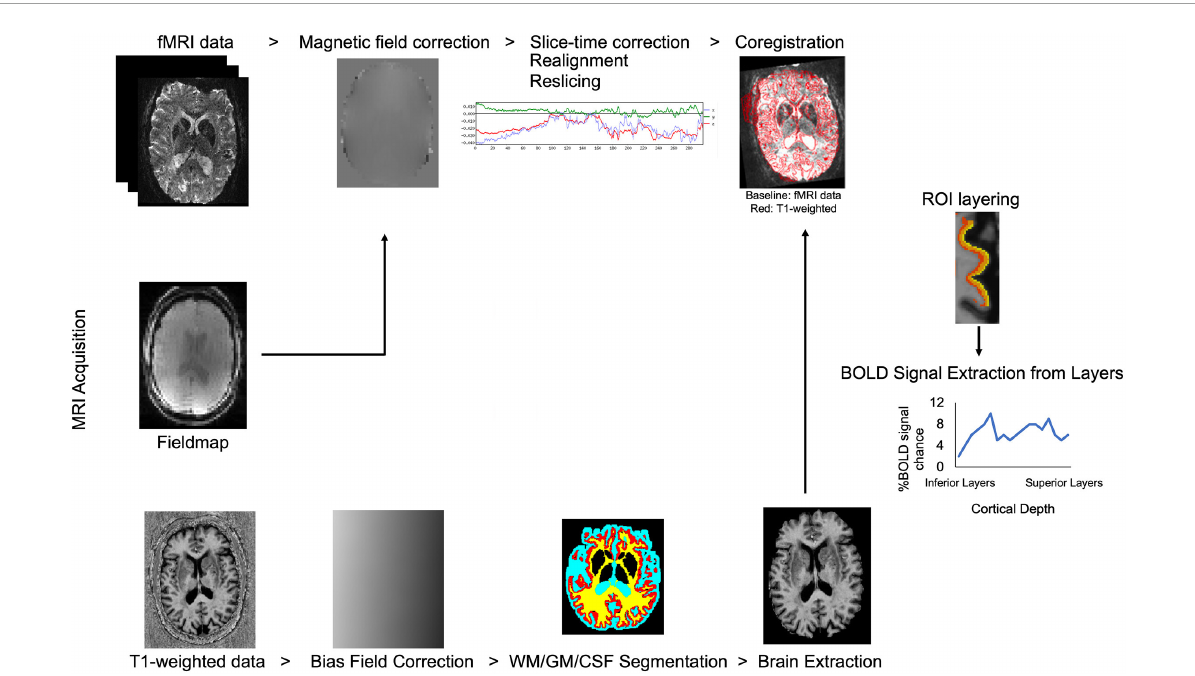
FIGURE2 Flow chart of laminar fMRI processing steps. Potential MRI sequences used in laminar fMRI studies are (from top to bottom of image) fMRI, field map, and T1 weighted sequences. Standard preprocessing steps for the fMRI data are listed left to right. T1 weighted data is corrected for bias field, segmented for white matter, gray matter, and cerebrospinal fluid and brain is extracted for better results in coregistration to the BOLD fMRI data. Regions-of-interest are created in the desired area and layered. The BOLD signal can be extracted from laminar